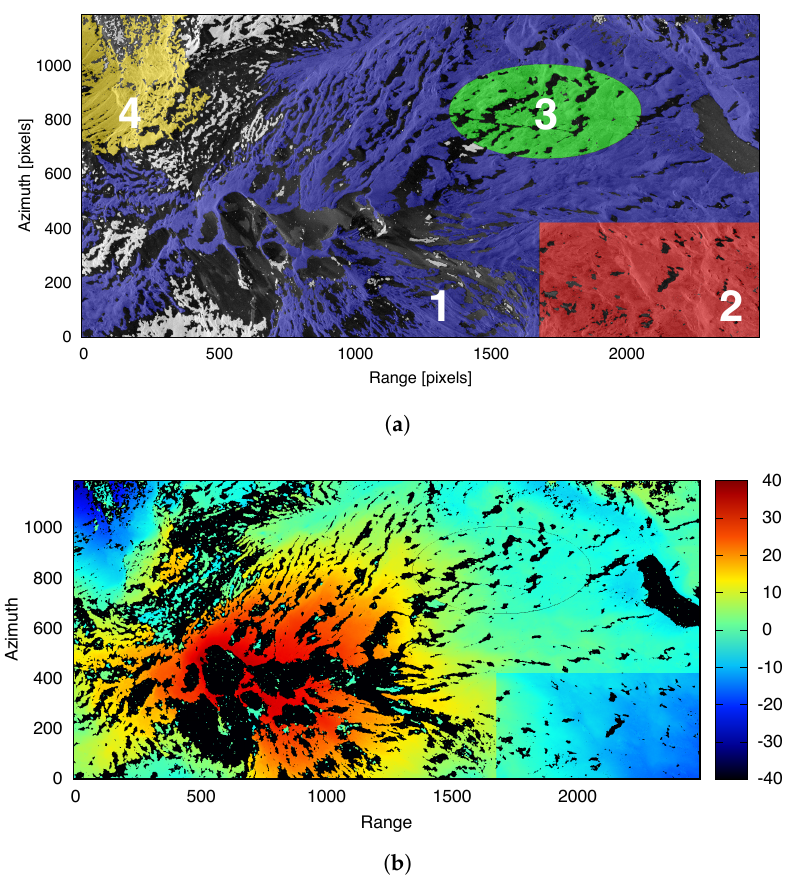
Figure 6. ( a ) map of the disconnected regions. The main coherent region from which areas have been artificially cut is represented in blue. We refer to the blue region, the red rectangle, the green ellipse and the yellow area, respectively, as the regions 1, 2, 3 and 4. Regions in black are regions with coherence lower than the threshold applied during phase unwrapping. White areas are naturally disconnected parts of the unwrapped phase and they are not considered for the validation of the SBInSAR-assisted phase unwrapping. ( b ) artificially disconnected version of the unwrapped phase over Copahue volcano. Color chart values are given in